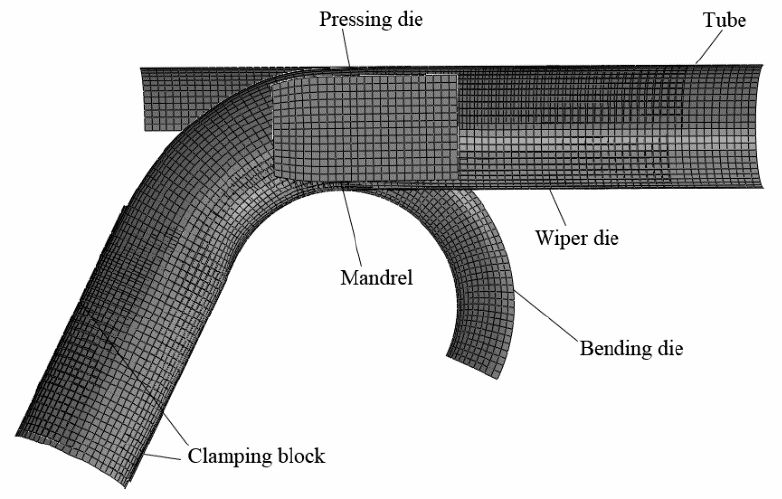
Figure 3. Finite element model.